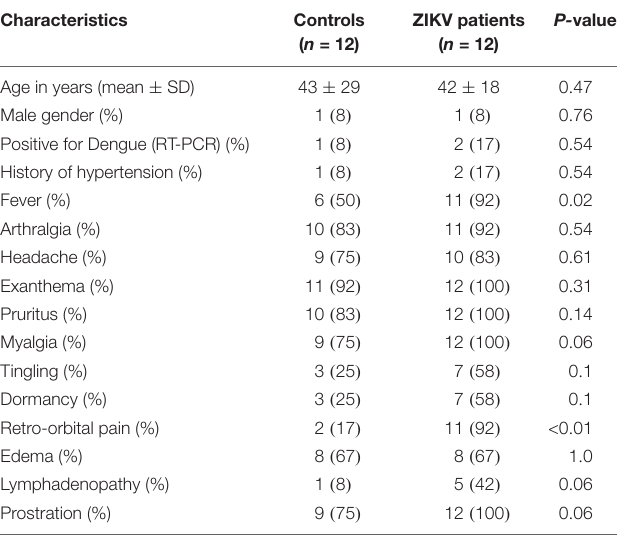
TABLE 1 | Clinical and demographic characteristics of ZIKV and control patients.